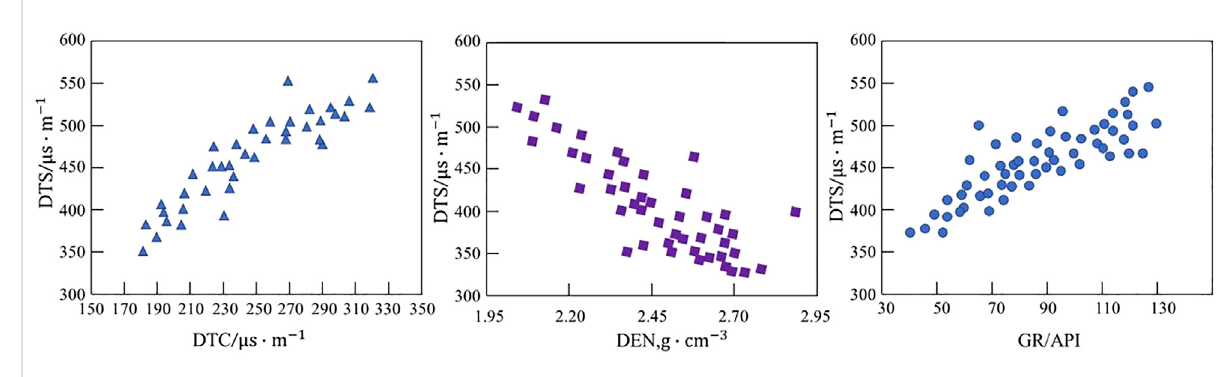
FIGURE 8 Cross plot of logging parameters and s-wave time difference (DTS).